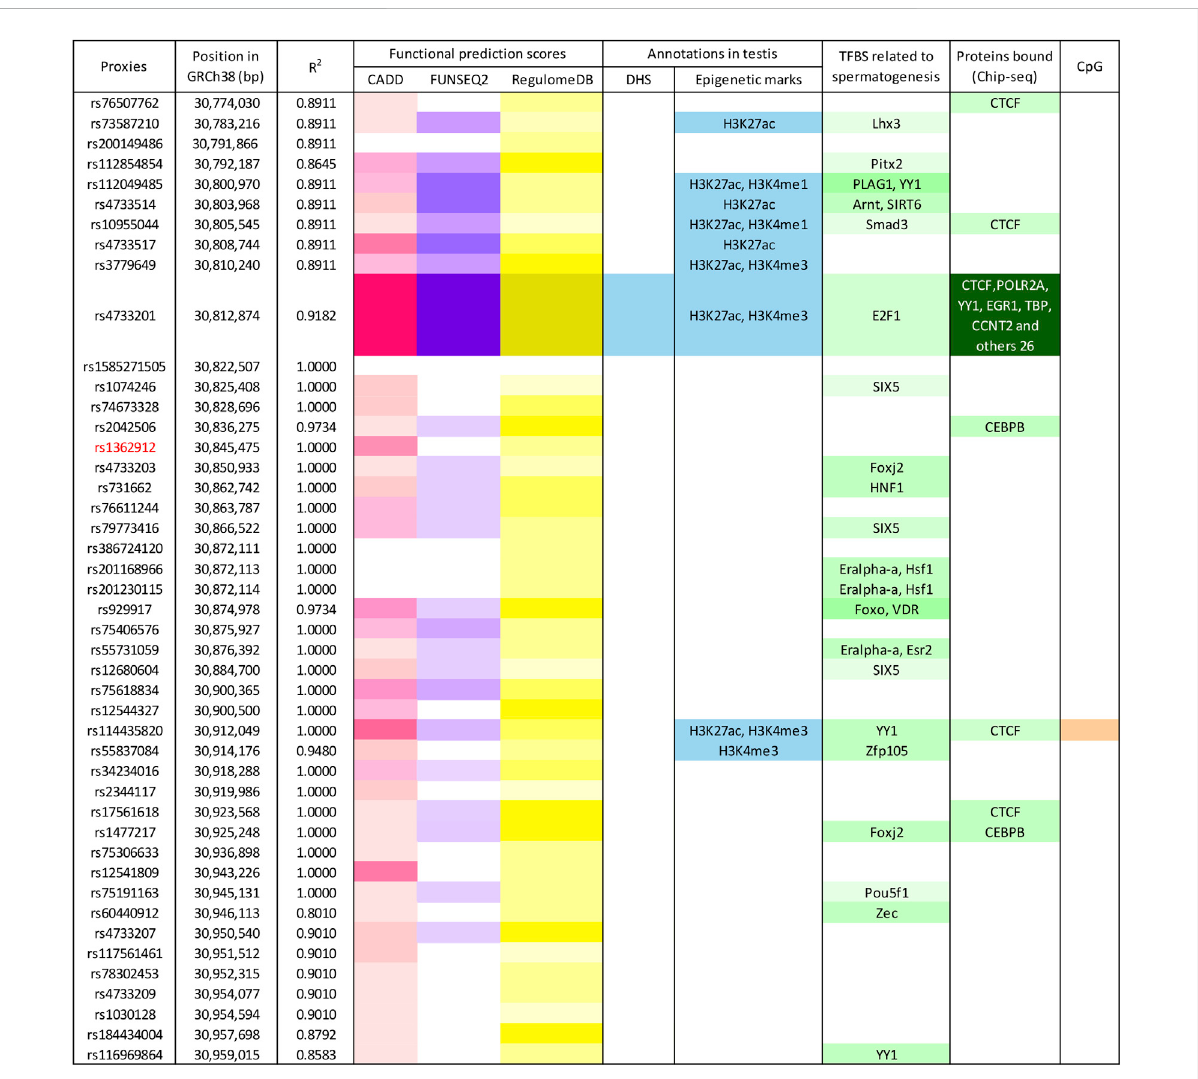
FIGURE 2 Enrichment in functional annotations of the human genome for TEX15 -rs1362912 and its proxies. Functional prediction scores, according to different algorithms, are marked in pink (CADD), violet (Funseq2), and yellow (RegulomeDB); blue-coloured cells represent overlap with functional annotations in testis based on the ENCODE and Roadmap Epigenomics projects; variants located within transcription factor binding sites (TFBS) relatedtospermatogenesis(basedoneitherpositionweightmatrixdataorChip-seq experiments)areshowningreen;andvariantsinCpGsites are highlighted in orange. Colour intensity is correlated with the probability or relevance (dark colours indicate higher probability). Bp, base pairs; GRCh38, Genome Reference Consortium Human Build 38; DHS, DNase I hypersensitive